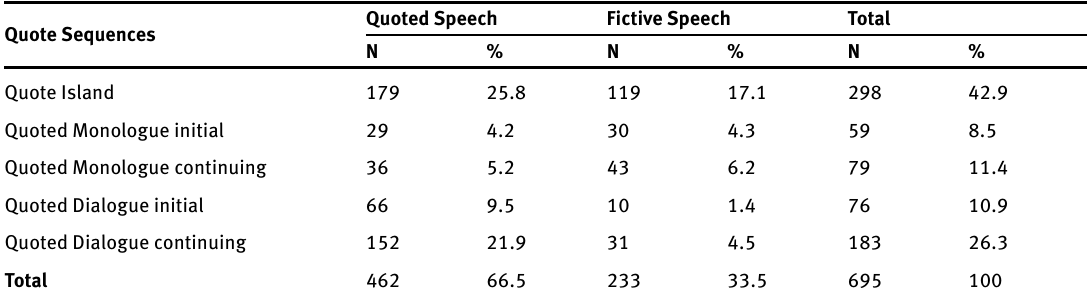
Table 2: Quoted and fictive speech in the three types of quote sequences